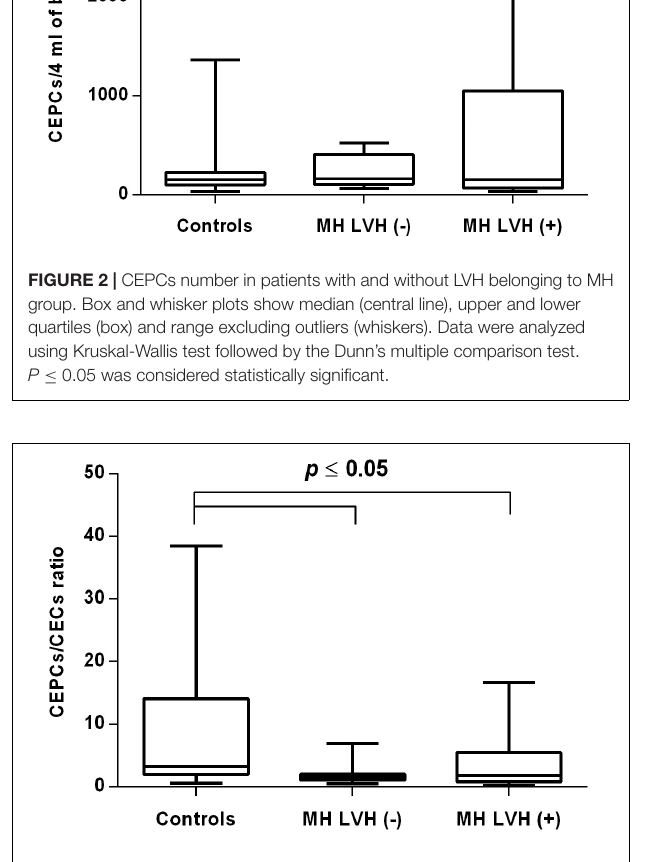
FIGURE 5 | CEPCs number in patients with and without LVH belonging to RH group. Box and whisker plots show median (central line), upper and lower quartiles (box) and range excluding outliers (whiskers). Data were analyzed using Kruskal-Wallis test followed by the Dunn’s multiple comparison test. P ≤ 0.05 was considered statistically